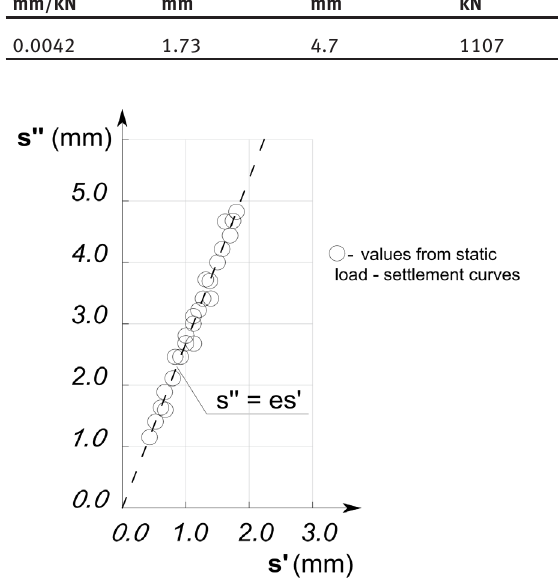
Figure 6: Relationship between the directional coefficients of the linear function s’’ and the non-linear function s’.